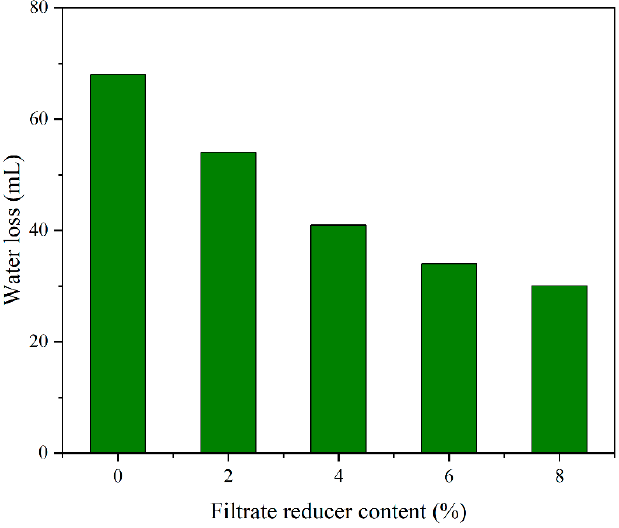
Figure 5. Water loss versus filtrate reducer